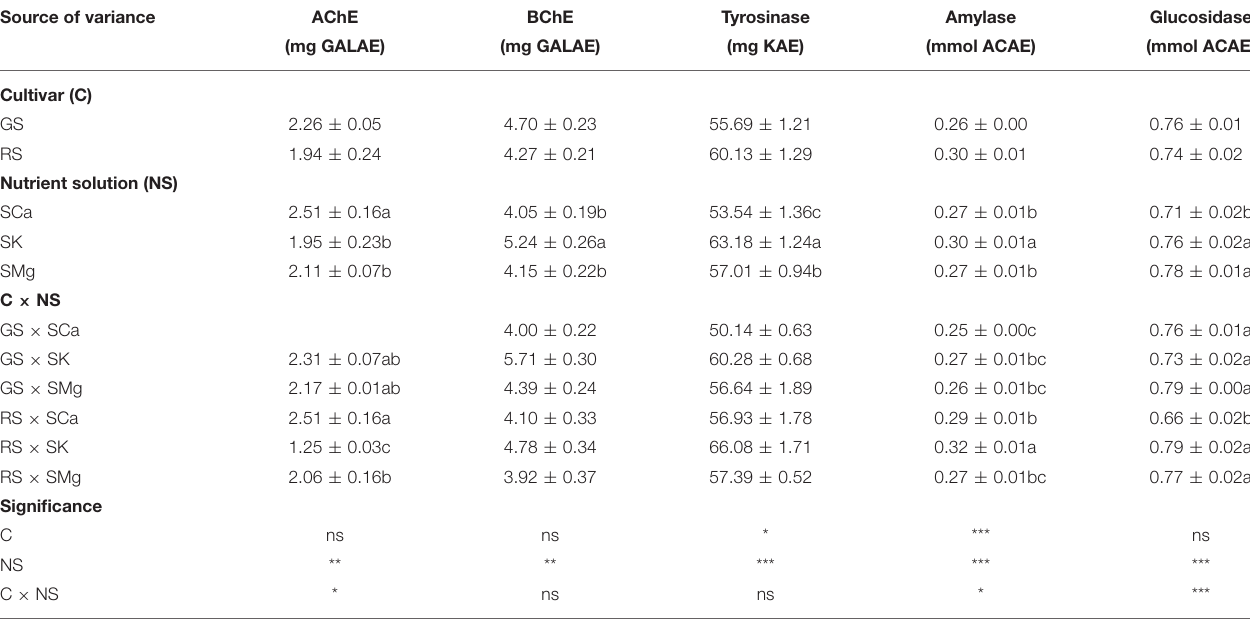
TABLE 7 | Effects of the C and of the NS of the enzymatic inhibitory properties of the leaf extract. Source of